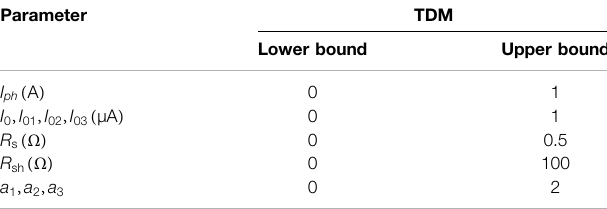
TABLE 5 | Parameter bounds of the TDM.